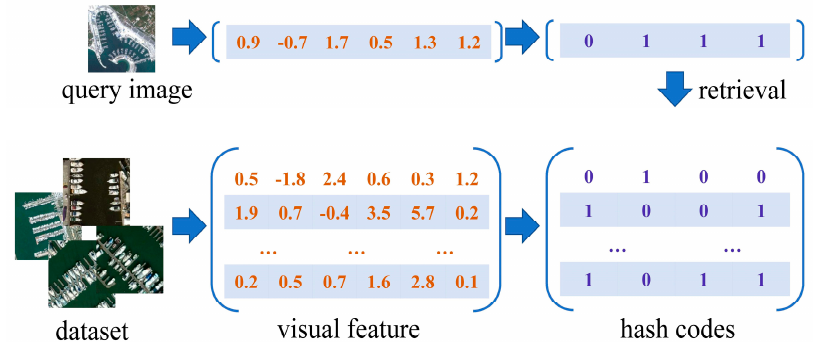
Figure 5. Schematic diagram of hash learning. In large-scale remote sensing image scene retrieval (RSISR), hash learning enormously reduces the storage while maintains the discriminating power of features, as well as transferring visual features to hash